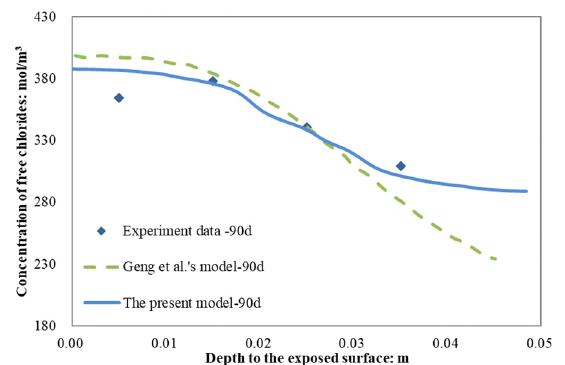
Figure 4. The comparison among experimental results, Geng et al.'s [50] fitting results and the numerical results. Adapted from